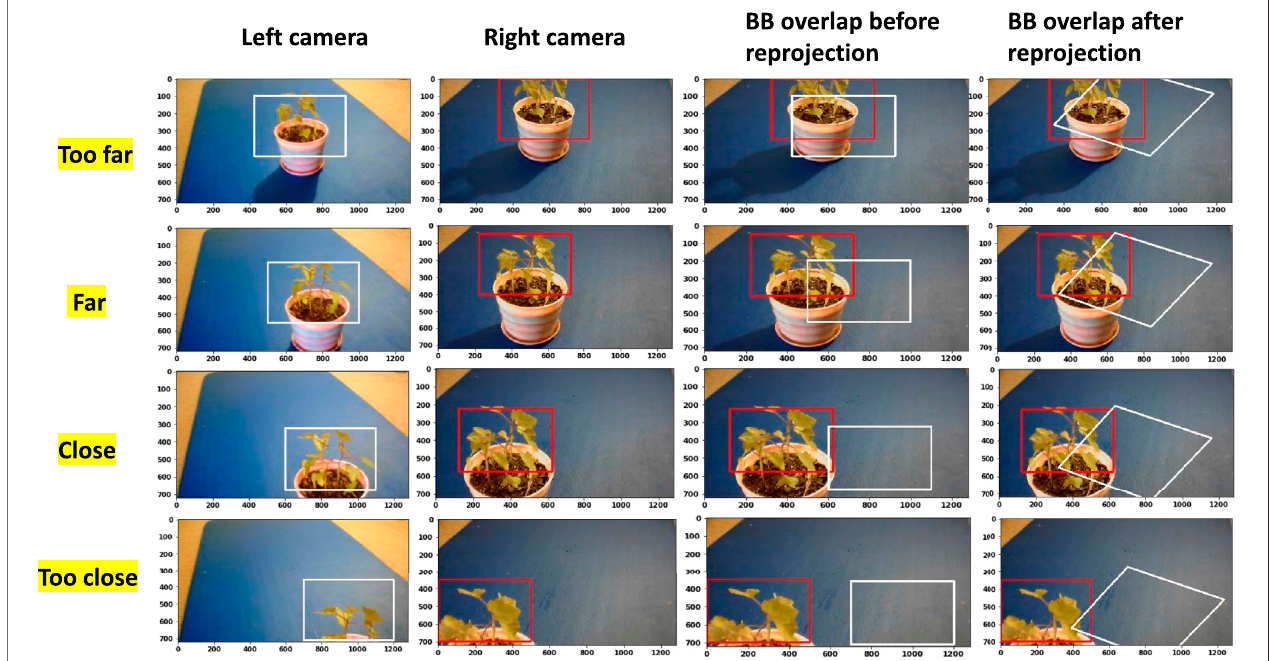
FIGURE5| HowBBoverlapchangeswhenweedisplacedatdifferentdistancesfromthecamera. “ toofar, ”“ far, ”“ close, ” and “ tooclose ” representthedistanceof the weed from the camera. “ After reprojection ” shows the BB overlap when the left camera image is reprojected using H . BB size, width: 500 pixels; height: 350 pixels.